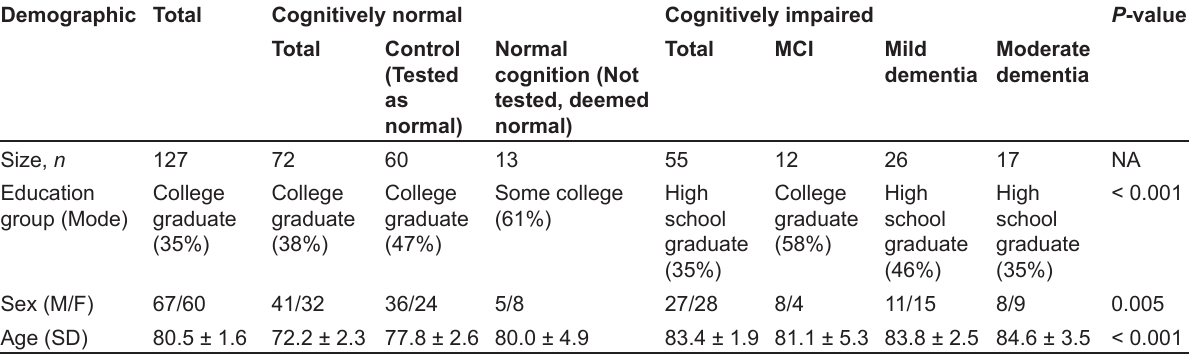
Table 1. Distribution of samples across different demographic groups Demographic Total Cognitively normal Cognitively impaired P -value